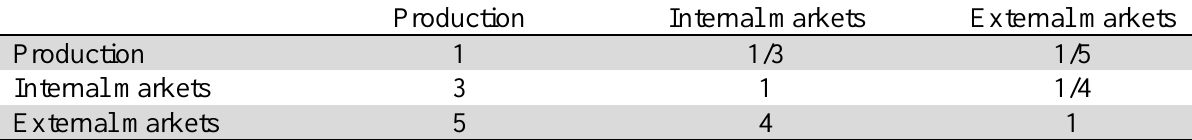
Fig. 2. Relative importance of departments by AHP Relative importance of IHCI’s sub-processes in one to nine Likert scale